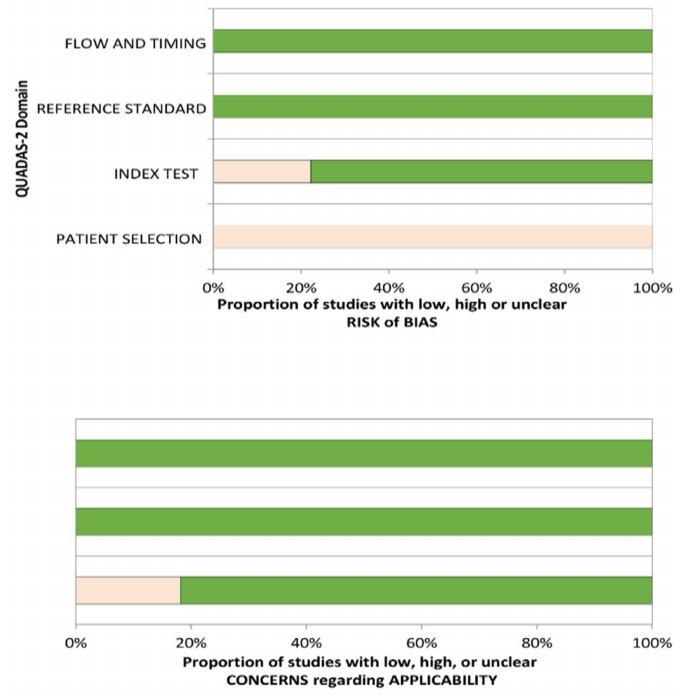
Figure 2. QUADAS-2 assessments of the included studies. Table 4. Diagnostic accuracy of mobile-linked POC diagnostic